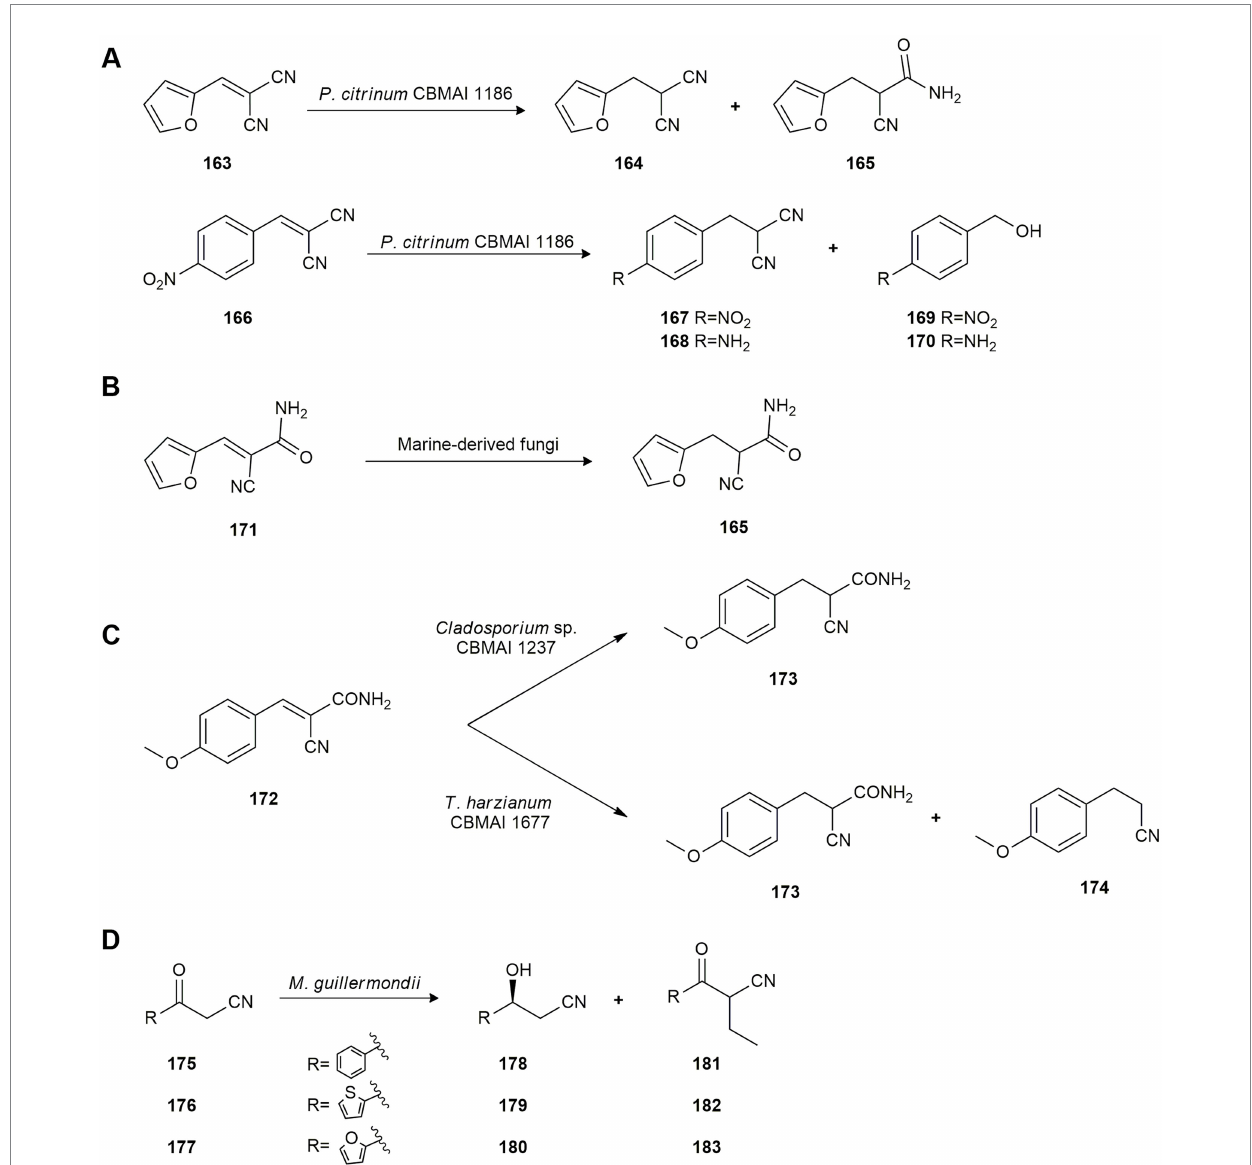
FIGURE 8 Biotransformations of cyano compounds. (A) Bioconversion of compounds 163 and 166 by Penicillium citrinum CBMAI 1186 (Jimenez et al., 2016). (B) Hydrogenation of E -2-cyano-3-(furan-2-yl)acrylamide ( 171 ) by P. citrinum CBMAI 1186, Trichoderma sp. CBMAI 932 and Aspergillus sydowii CBMAI 935 (Jimenez et al., 2019). (C) Reduction of ( E )-2-cyano-3-(4-methoxyphenyl)acrylamide ( 172 ) by marine-derived fungi (Birolli et al., 2020). (D) Reduction of 3-oxo-3-arylpropanenitriles 175–177 by Meyrozyma guillermondii UBOCC-A-214008 (Serra et al.,